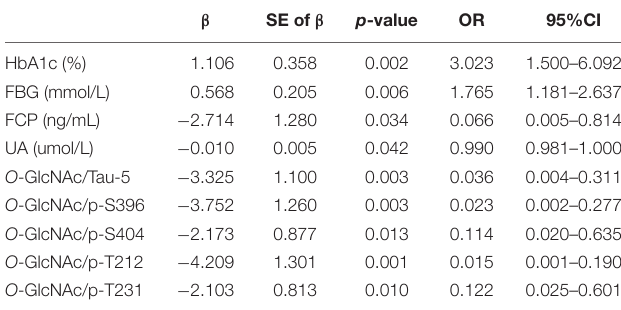
TABLE 2 | Exploration of risk factors for MCI in T2DM